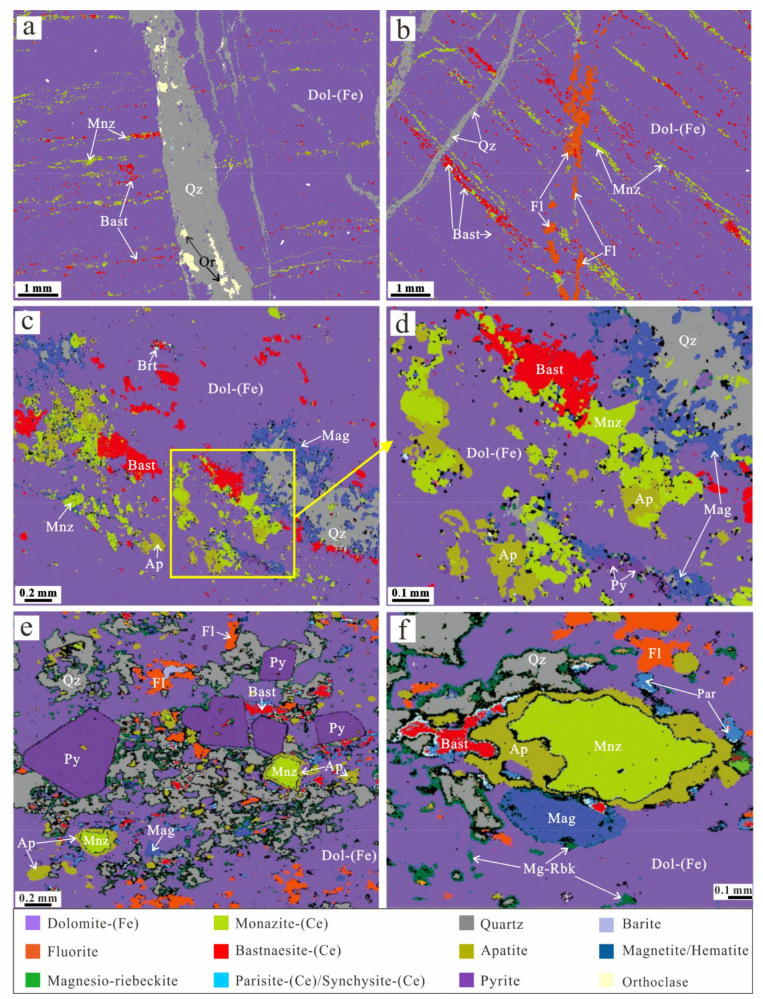
Figure 10. The TIMA mineral phase map showing the vein cut relationship and metasomatic alteration texture from the drill ore samples. ( a ) the later relatively thick quartz veins cut the near parallel monazite-(Ce), and bastnäsite-(Ce) aggregate veinlets; ( b ) REE veinlets were also cut by REE-poor and late-stage fluorite and quartz veinlets; ( c ) monazite-(Ce) and bastnäsite-(Ce) commonly intergrown with apatite and barite, associated with magnetite and quartz, overprinting on the dolomite-(Fe) matrix; ( d ) the close-up image of the yellow square from the figure ( c ), show monazite-(Ce) intergrowth or overgrowth along with the apatite; and magnetite overgrowth around the grain boundaries of quartz; ( e ) the disseminated dolomite-(Fe) REE ores showing the presence of pyrite, quartz, magnetite, fluorite, as well as individual monazite-(Ce) with apatite overgrowth along its rim; ( f ) the individual monazite-(Ce) was usually partially replaced and overgrown by apatite and bastnäsite-(Ce), showing a alteration texture, in the disseminated dolomite-(Fe) REE ores. Abbreviations: Dol-(Fe), dolomite-(Fe); Mnz, monazite-(Ce); Bast, bastnaesite-(Ce); Fl, fluorite; Ap, apatite; Mag, magnetite; Qz, quartz; Py, pyrite; Par, parisite-(Ce); Brt, barite; Mg-Rbk, magnesio- riebeckite; Or,